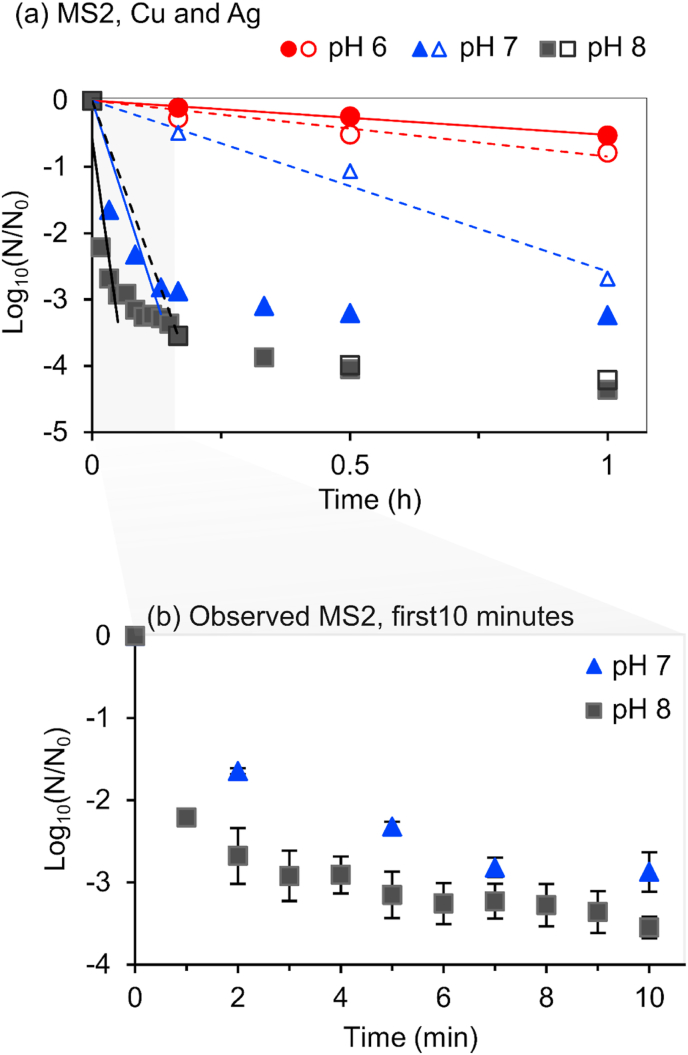
First hour inactivation of (a) MS2 by Cu and Ag ions combined as observed (closed marker) and the mathematical sum of LRVs obtained through individual treatment as estimated (open marker). (b) The first 10 min of observed MS2 inactivation by Cu and Ag. Regression lines are in same colour as the pH markers (For colour interpretation, the reader is referred to the web version of the article). (For interpretation of the references to colour in this figure legend, the reader is referred to the Web version of this article.)